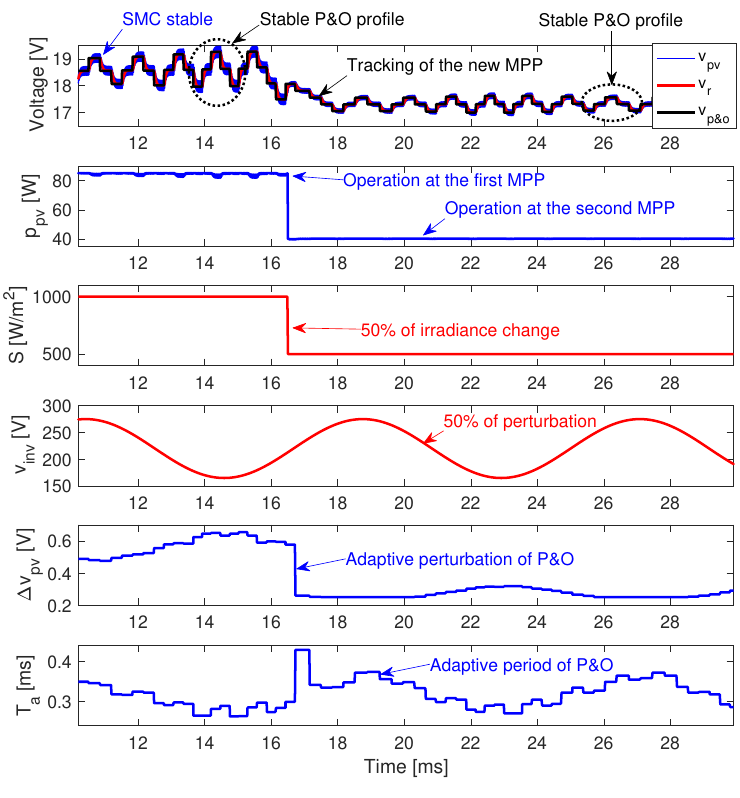
Figure 14. Performance of the PV system with the auto-tuned